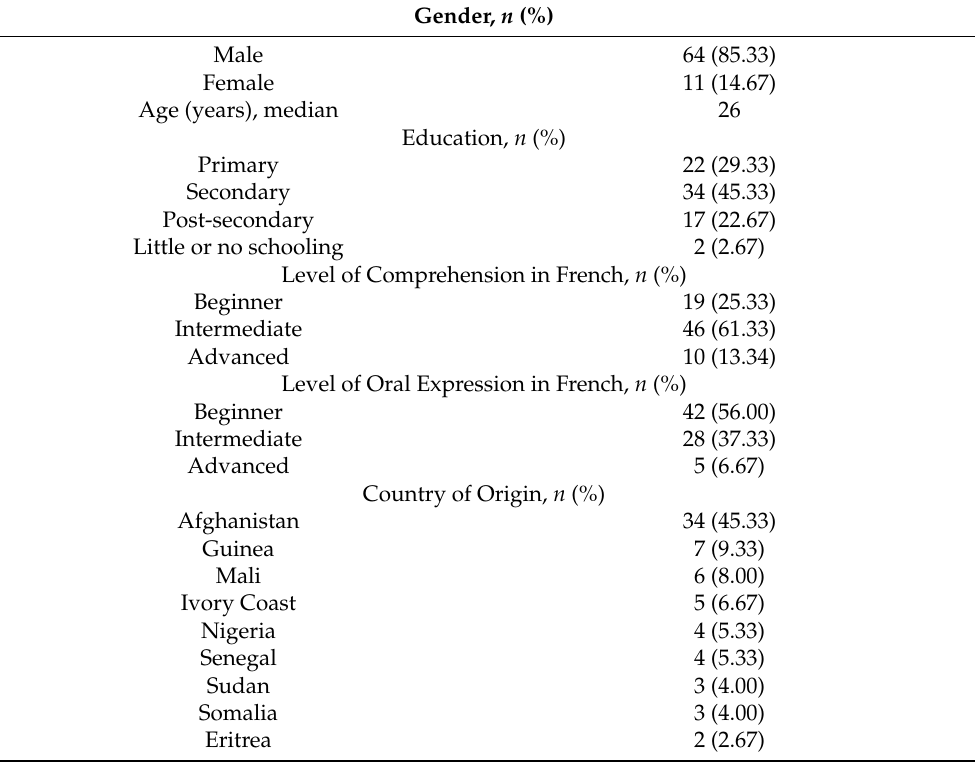
Table 2. Sociodemographic characteristics of study sample ( n =